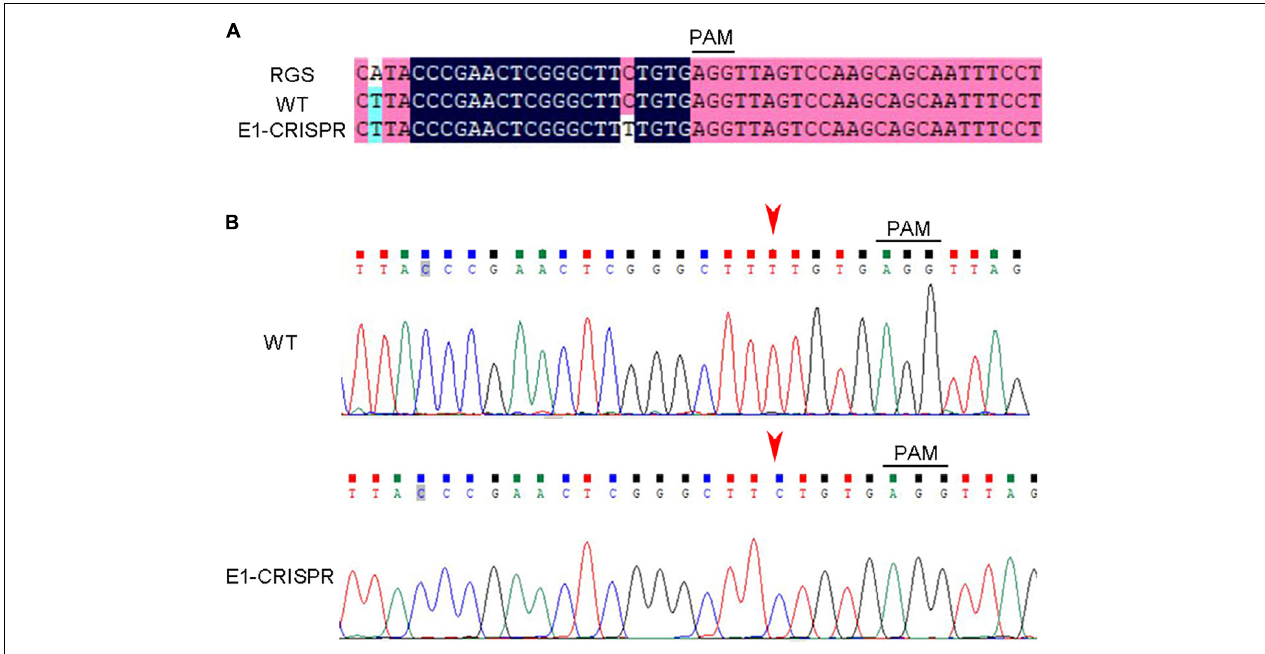
FIGURE 4 | CRISPR/Cas9-mediated mutations in oyster D-larvae delivered by electroporation. (A) Comparison of sequencing results between wild type and edited larvae. (B) Sequencing traces of the target region of CaPitx . The PAM sequence is underlined by the black bar. The red arrow indicates the mutation site. PAM, protospacer adjacent motif. RGS, reference genome sequence. WT, wild-type. “E1-CRISPR” represent D-larvae developed from an electroporated